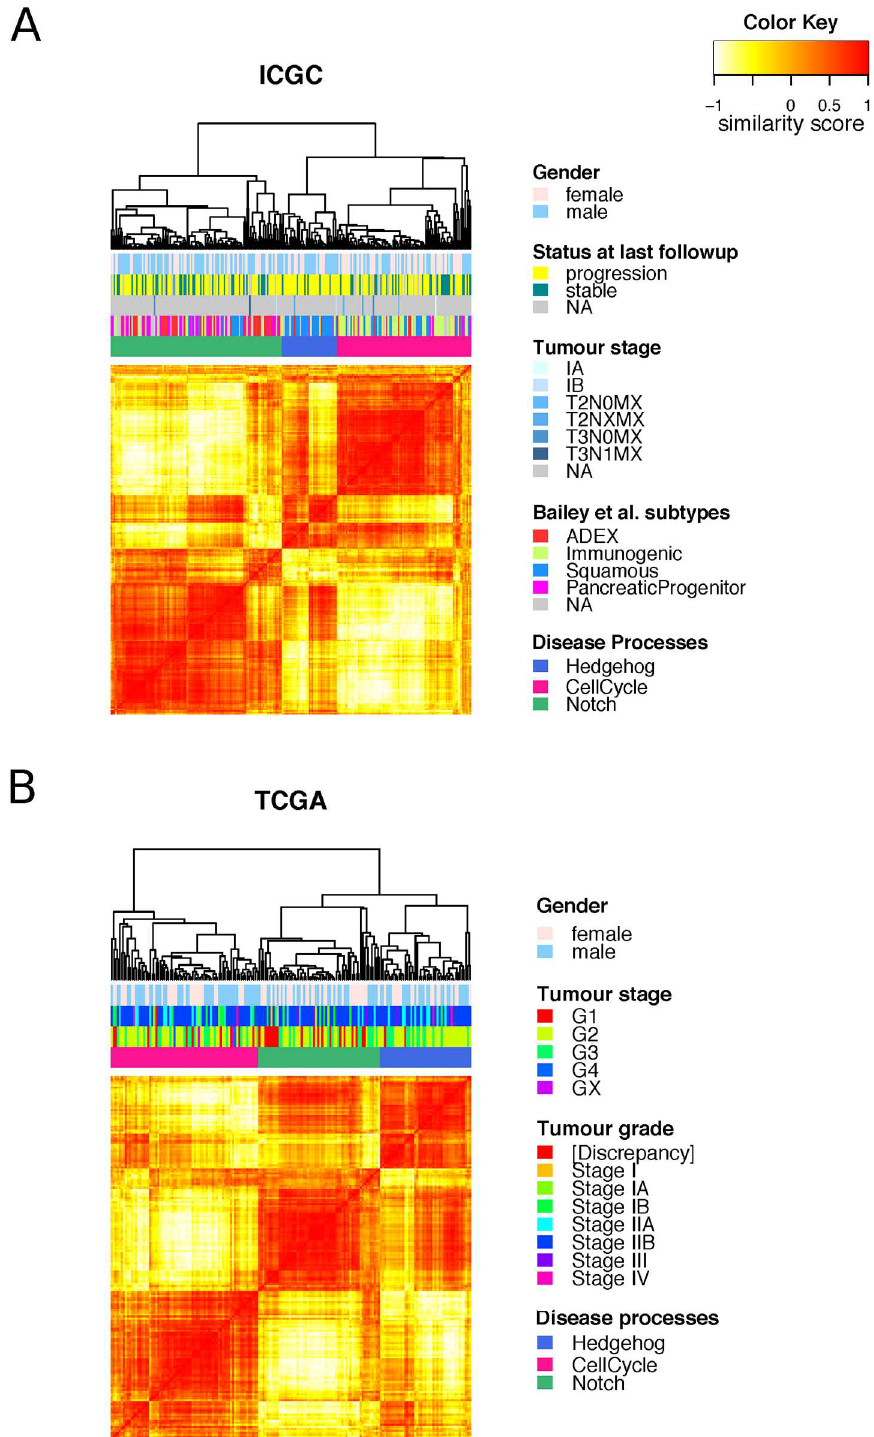
Fig 2. Clustering of masterregulators into different functional groups. Heat maps showingthe similarity betweenthe samplesin the A . ICGC and B . TCGA cohorts as measuredby “signature distance” betweenthe MRs activity profiles [27]. Unsupervisedanalysisidentified three classes of tumours with differentialactivities of the three identifieddiseaseprocesses: cell cycle (pink), Hedgehog/Wnt (blue), and Notch (green).